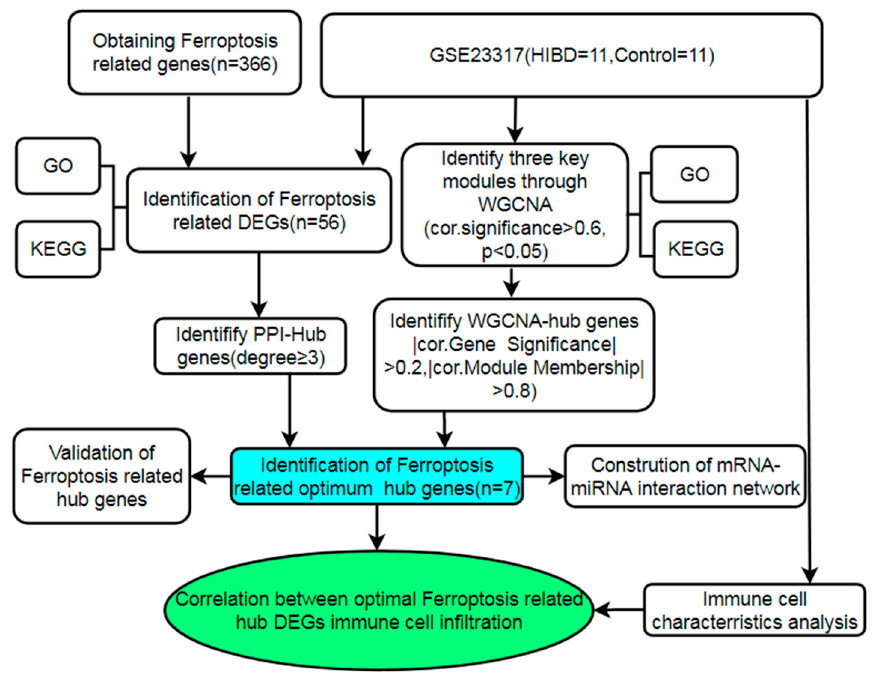
Figure 1. Flow chart of investigations in this study.